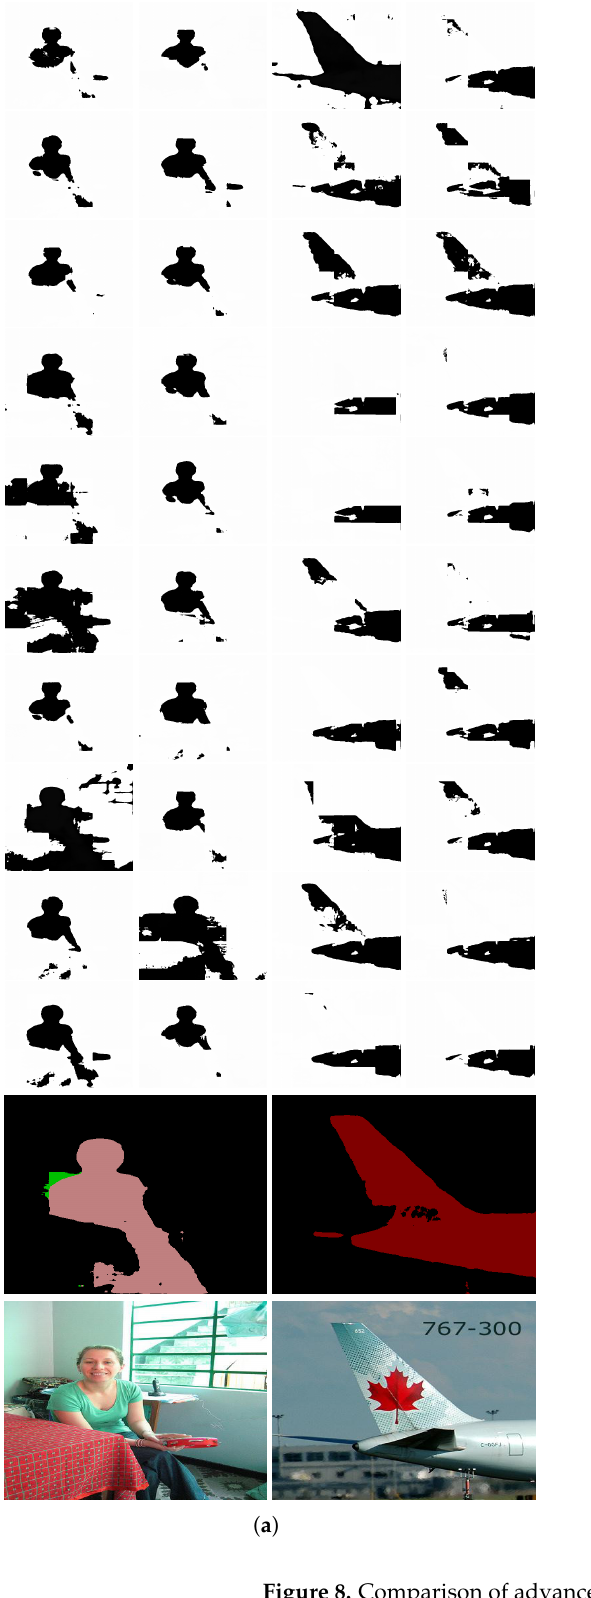
Figure 8. Comparison of advanced feature maps and prediction: ( a ) feature map and prediction of the HyperSeg network before adding bokeh, the last row is the input image. ( b ) Feature map and prediction of the HyperSeg network after adding bokeh, the last row is the ground truth. The feature map does not include background